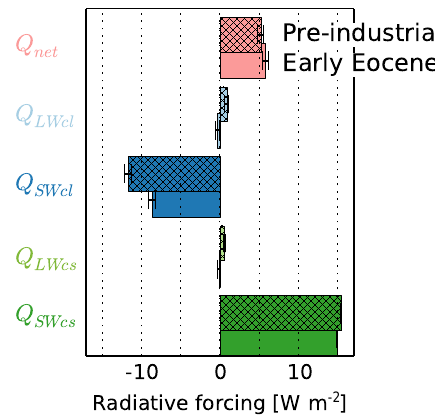
Figure 5. Net radiative forcing and its single components for the comparison of the forest world to the bright desert world. Hatched and plain bars show the radiative forcings for the pre-industrial cli- mate and the early Eocene climate, respectively. The error bars refer to the 95% confidence interval.